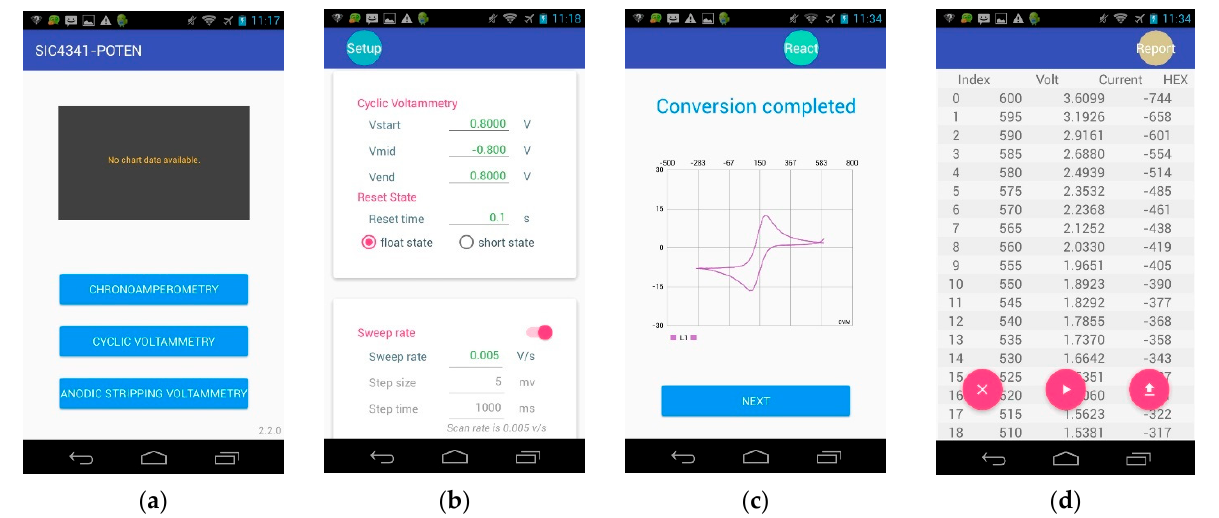
Figure 1. Smartphone screenshots showing the SIC4341-POTEN Android application: ( a ) initial screen, ( b ) electrochemical parameters settings, ( c ) cyclic voltammogram and ( d ) resulting data.